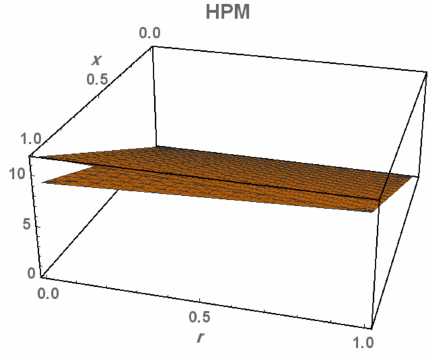
Figure 11. Solution of the tenth-order double parametric fuzzy HPM at t = π , b = 0.4, 0.6 for all x ∈ [ 0,1 ] and r ∈ [ 0,1 ]